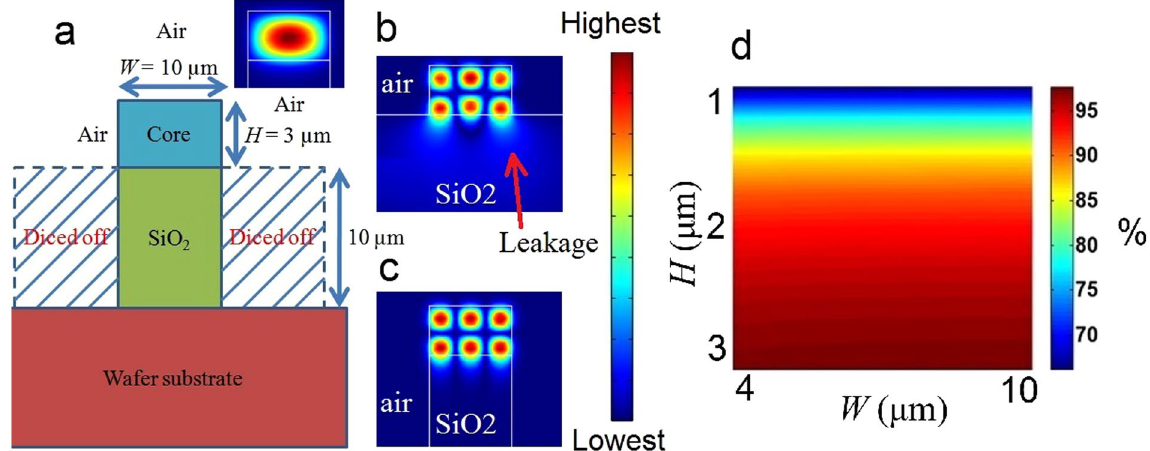
Figure 2. Design of proposed high gain air cladded channel waveguide and the theoretical modeling of its performance. ( a ) Cross section design of PWA; simulated fundamental mode in subset ( b ) leaky higher order mode, and ( c ) non-leaky higher order mode of our designed PWA ( d ) Optical field confinement of our PWA.